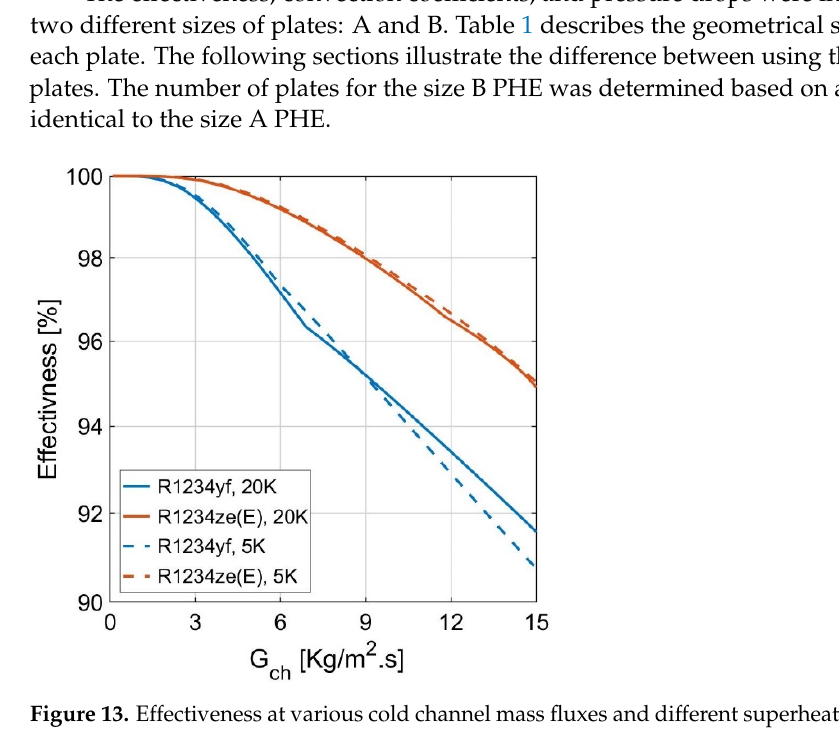
Figure 12. Cold stream two-phase convection coefficient at various cold channel mass fluxes and different superheat temperature differences.